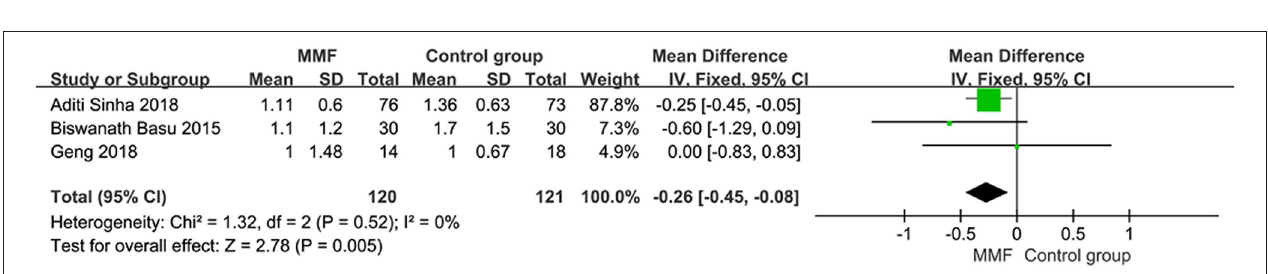
FIGURE 4 | Forest plot showing mean difference (MD) of the number of relapses within 1 year between the